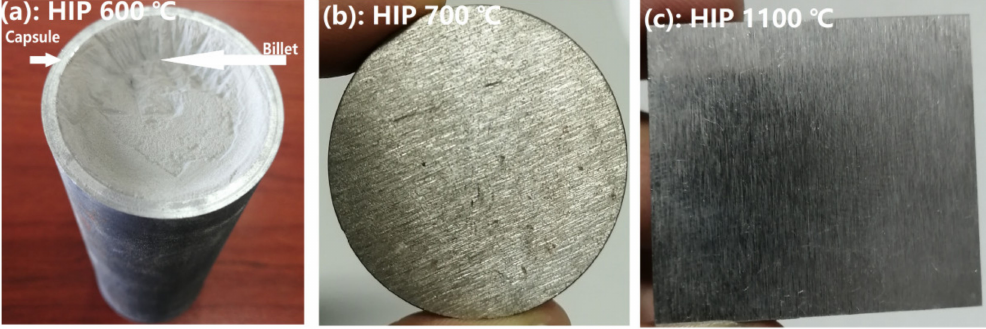
Figure 10. Photographs of samples by HIP at ( a ) 600 °C, ( b ) 700 °C, and ( c ) 1100 °C.